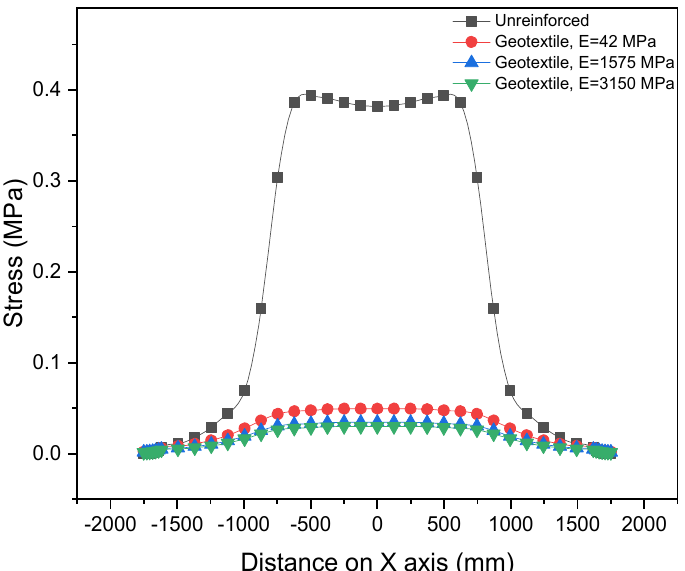
Figure 8. Comparison of stress distribution on top of the subgrade for geotextiles of varying elastic modulus.